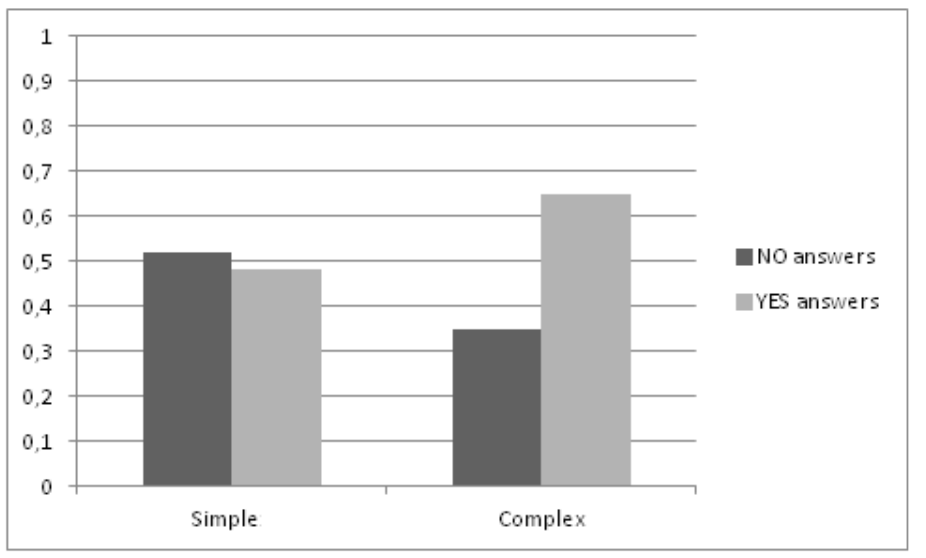
Figure 12 . Proportion of YES and NO answers per type of wh -phrase